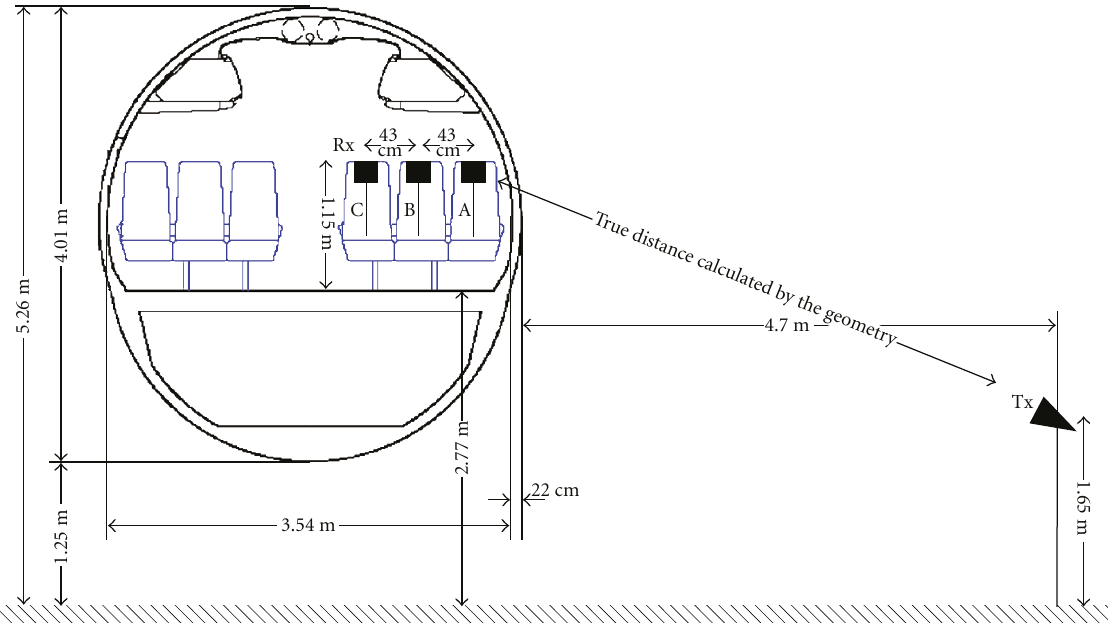
Figure 5: Cross-section of the attenuation measurement configuration.